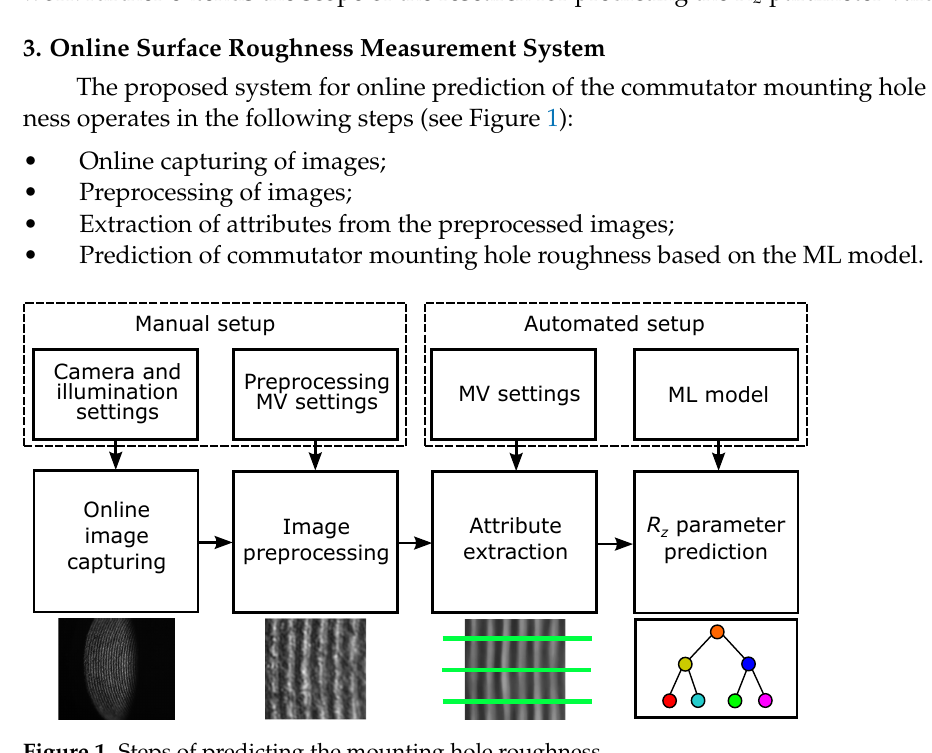
Figure 1. Steps of predicting the mounting hole